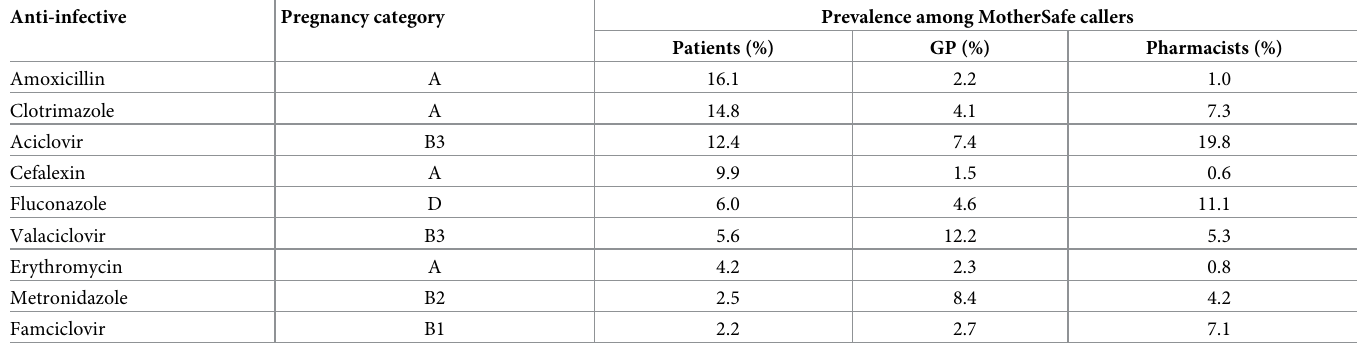
Table 3. Top ranked enquiries by caller regarding anti-infective drugs with pregnancy category and prevalence.